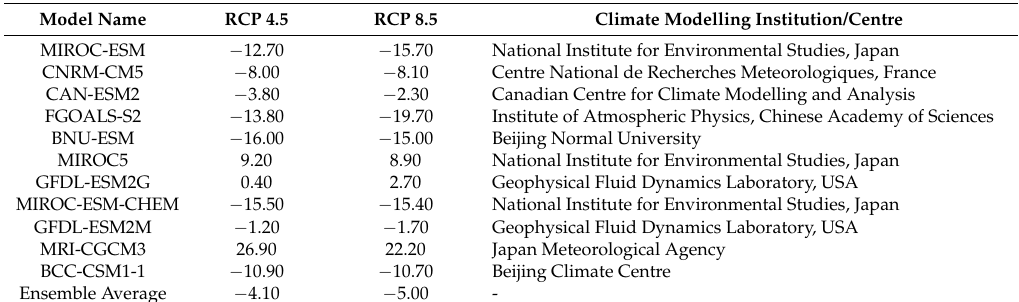
Table 1. Details of the GCM models used and their bias (%) in the height of precipitation for the historical period from 1984–2013.